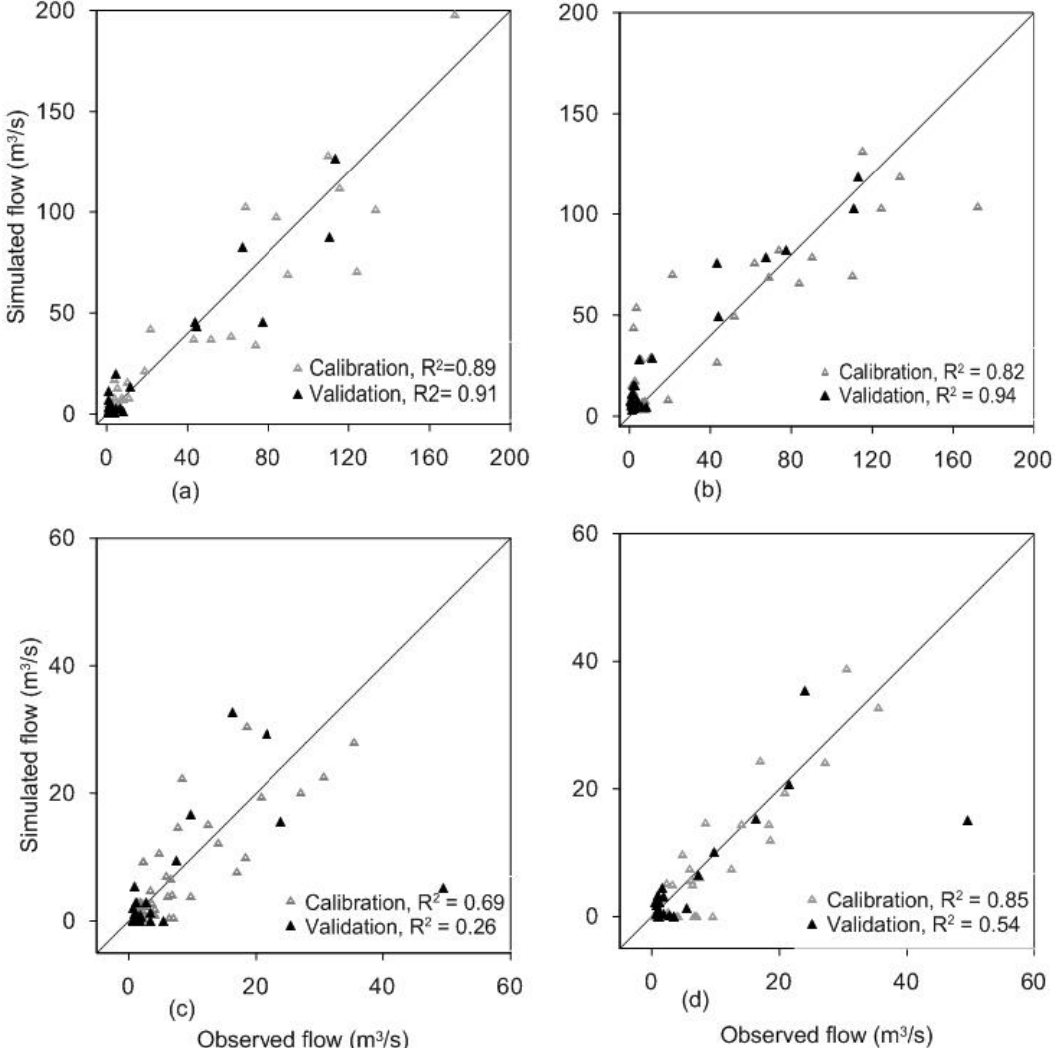
Figure 9. Observed vs. simulated streamflow scatter plots. To simulate the patterns, the weather data used were ( a ) conventional at Melka Kunture, ( b ) CFSR at Melka Kunture, ( c ) conventional at Keleta, and ( d ) CFSR at Keleta.